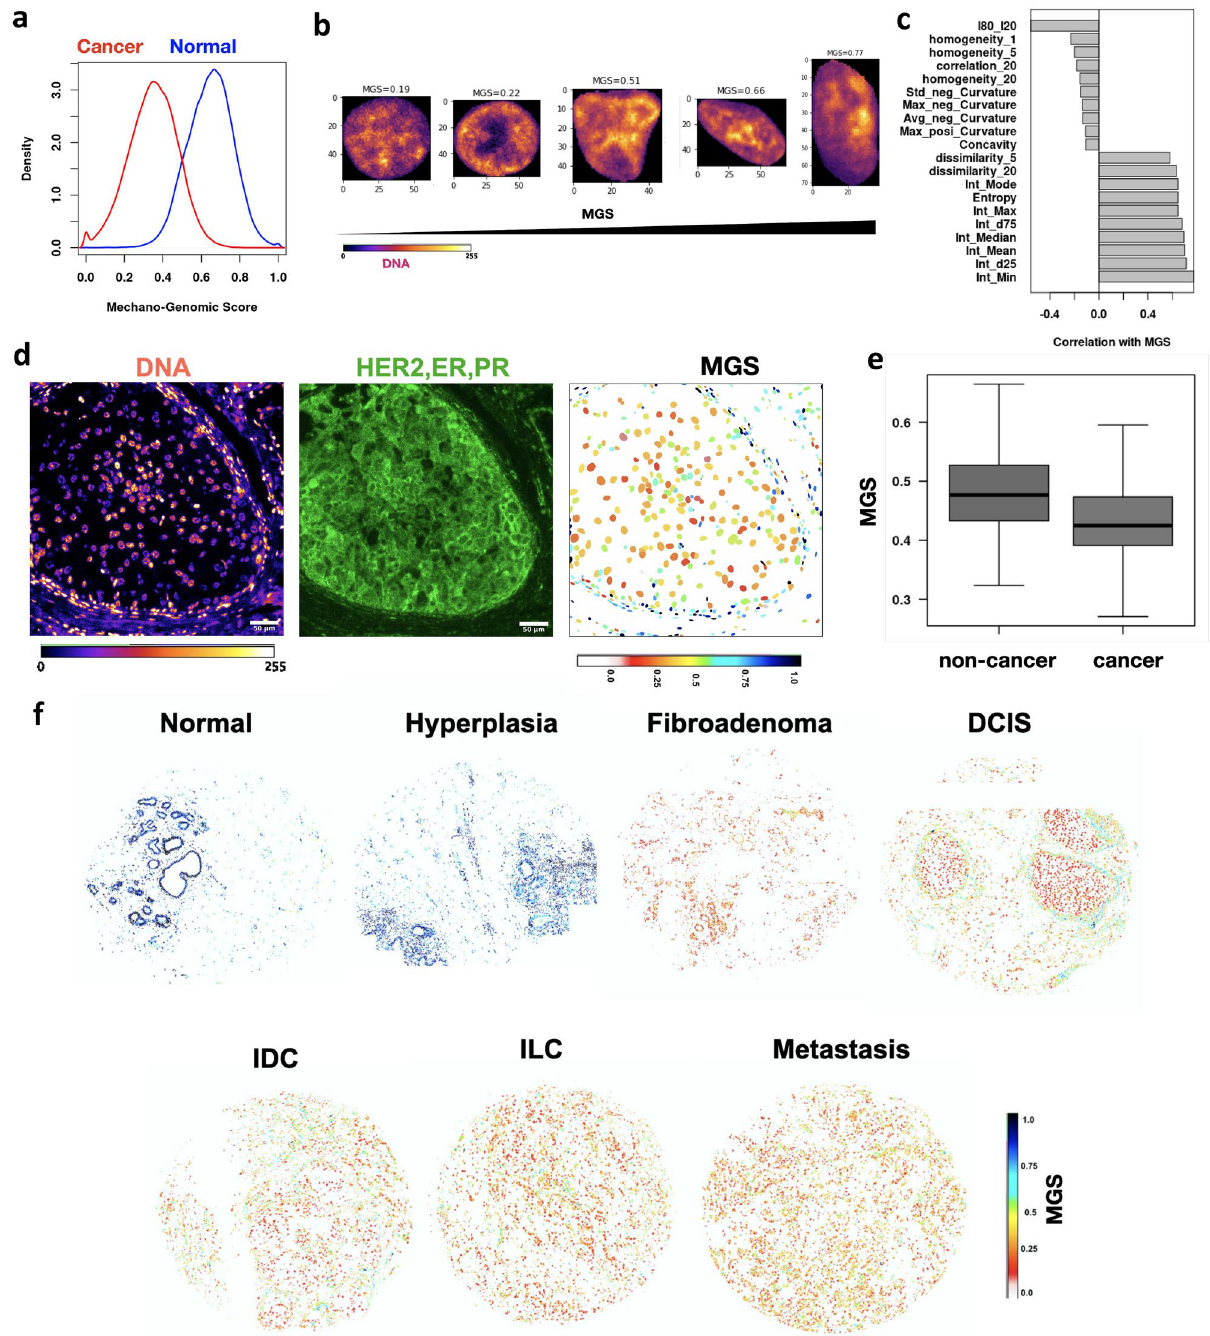
Figure 4. Single cell Mechano-Genomic Score that reflects breast cancer progression. ( a ) Probability density histograms of Mechano-Genomic Score (MGS) for nuclei from normal tissues (blue) and invasive cancer tissues (red) (Wilcoxon Rank Sum Test p-value < 0.001). ( b ) Representative images of nuclei stained for DNA (fire colors) with increasing MGS values (the top margin). ( c ) The top 10 features with the highest or lowest pearson correlation coefficients with MGS. Please note that the number following the features refers to the length scale of the GLCM texture features. ( d ) Micrograph of DCIS tissue sections stained for DNA and Biomarker (HER, ER and PR cocktail). Each nuclear boundary is colored based on the MGS of the corresponding nucleus. The color code is on the bottom right. ( e ) MGS of nuclei within and outside the cancer regions. Wilcox Test p-value < 0.0001 for E and F. n ~ 800. ( f ) Visualizing the MGS at single cell resolution for representative TMA of varying breast cancer stages. Each nucleus is colored based on its MGS. The color code is on the bottom